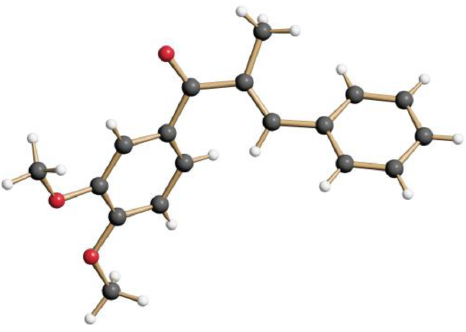
Figure 1. Structure of the α-methyl E -chalcone 3 (s-trans configuration) in the crystal.